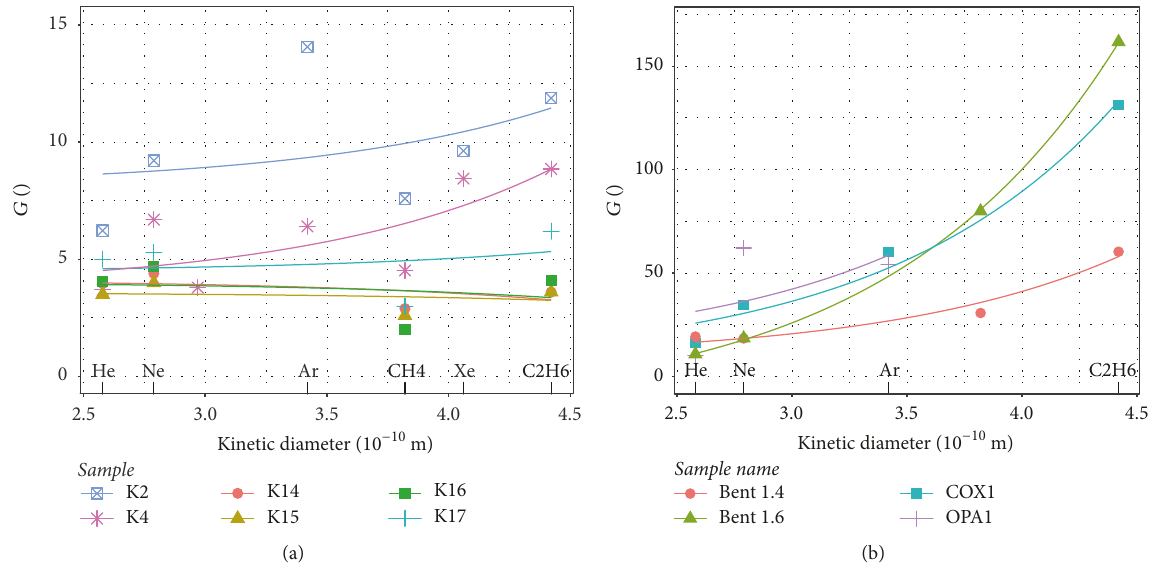
Figure 3: Geometric factors for dissolved gases in Boom Clay (a) and other clayey materials